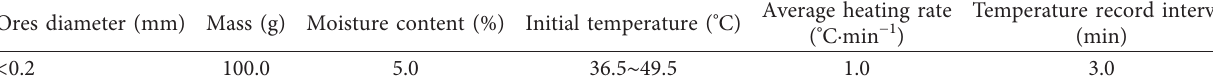
Table 1: Main experimental